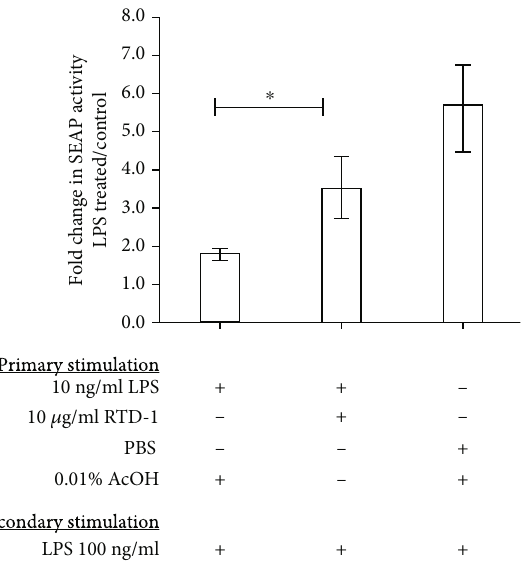
Figure 4: RTD-1 inhibits the establishment of endotoxin tolerance. THP-1 cells were incubated with 10ng/ml LPS and RTD-1 for 20 h as indicated. Cells were washed and restimulated with 100 ng/ml LPS for 4h. TNF- α secretion in the medium was analyzed by ELISA after primary stimulation (white columns) and secondary stimulation (black columns). The average of 3 experiments is shown; NS: nonsigni fi cant, P = 0 : 949 two-tailed, paired t test. Primary LPS exposure suppresses endotoxin tolerance.